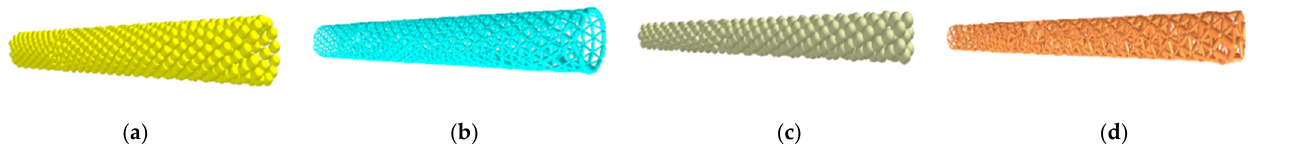
Figure 3. Bonding bond model. ( a ) Surface skin discrete element model. ( b ) Surface skin particle bonding. ( c ) Inner flesh discrete element model. ( d ) Inner flesh particle bonding.